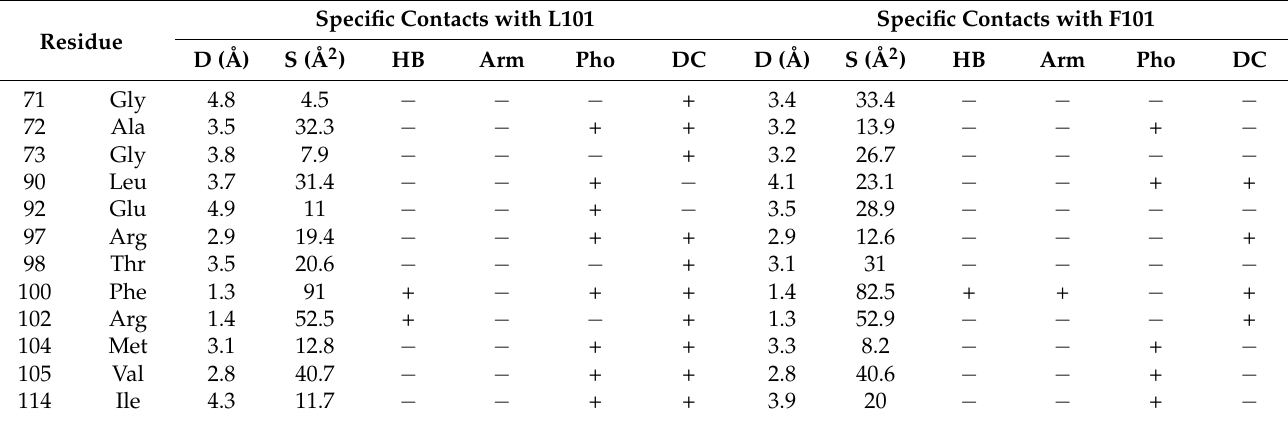
Figure 2. Interatomic contacts among residues that occur at the polymorphic site: ( A ) L101 (wild-type) and ( B ) F101 (mutant). Polymorphic residues (sticks) are depicted in cyan, while the others are displayed using the element-coloring settings. Non-covalent interactions are presented in default colors, as stated in the Arpeggio server. Table 4. Residues in contact with L101 (wild-type) or F101 (mutant) in the Mt GidB 3D structure. Classification of non- covalent interactions as detected by the LPC/CSU software